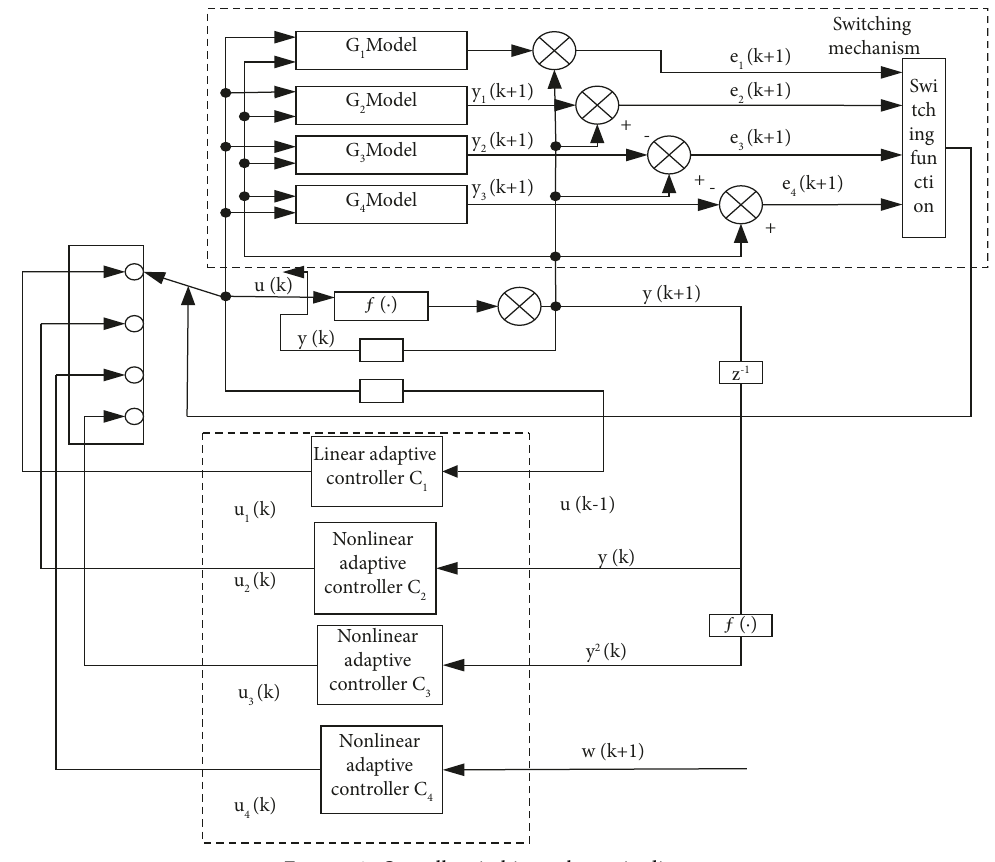
Figure 2: Overall switching schematic